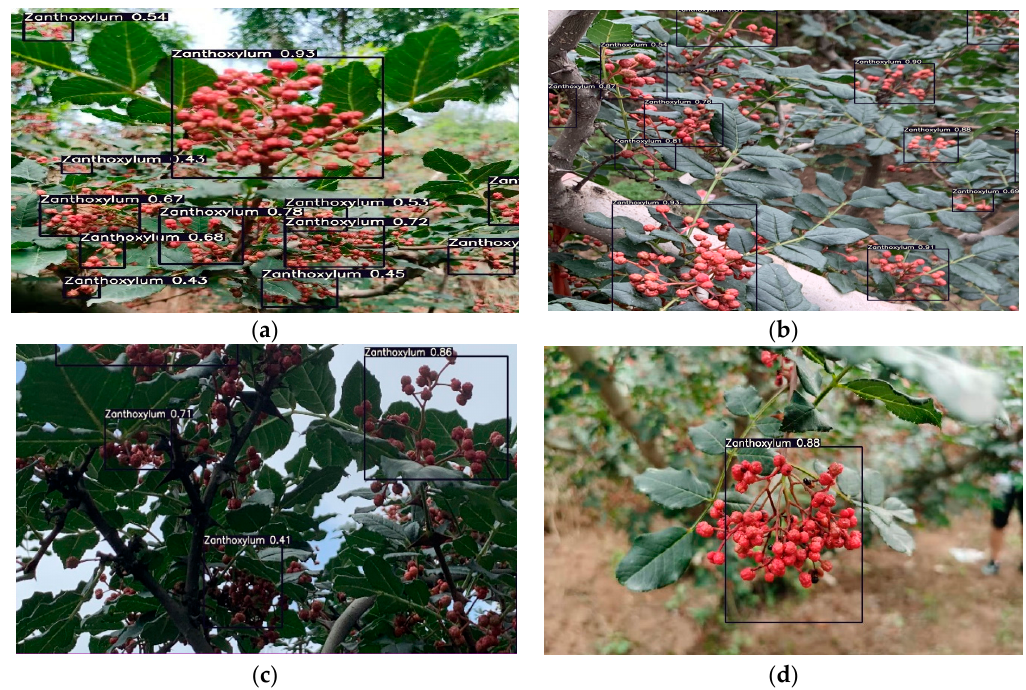
Figure 11. Recognition results of Zanthoxylum by the improved YOLOv5s network in the morning. ( a ) Multiple clusters of blocked Zanthoxylum fruit. ( b ) Multiple clusters of unblocked Zanthoxylum fruit. ( c ) Single cluster of Zanthoxylum fruit under backlight. ( d ) Single cluster of Zanthoxylum fruit under sunlight.